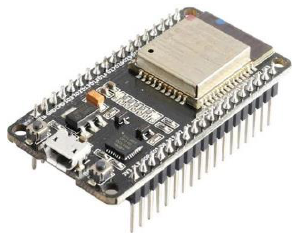
Figure 6. ESP32 Microcontroller [24].